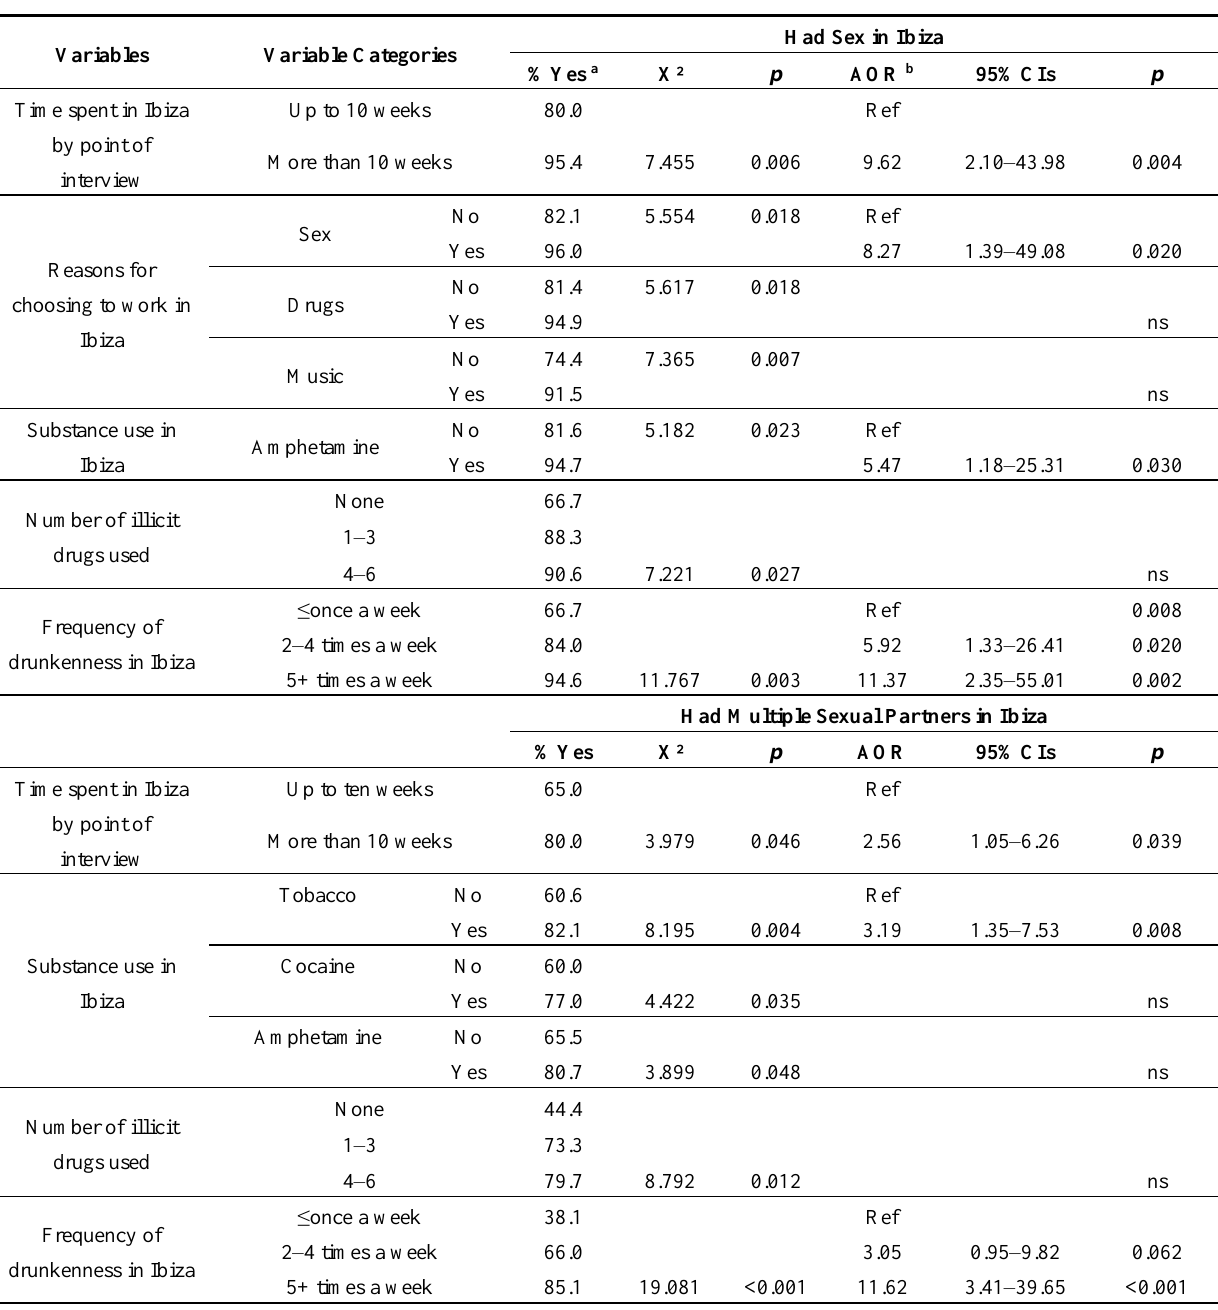
Table 2. Factors associated with having sex and having multiple sexual partners among those arriving in Ibiza without a sexual partner *.